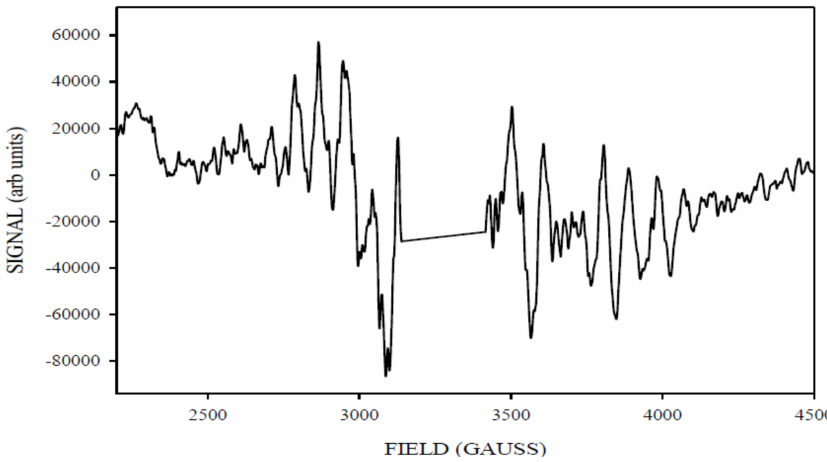
Figure 4. The X-band CW-EPR-generated difference ML signal obtained corresponding to light ( ≈ 140 K NIR illumination) minus annealed spectra. Spectrometer conditions: 15 G modulation ampli- tude, center field 3400 G, sweep width 2500 G, 0.5 mW microwave power, frequency 9.369126 GHz,